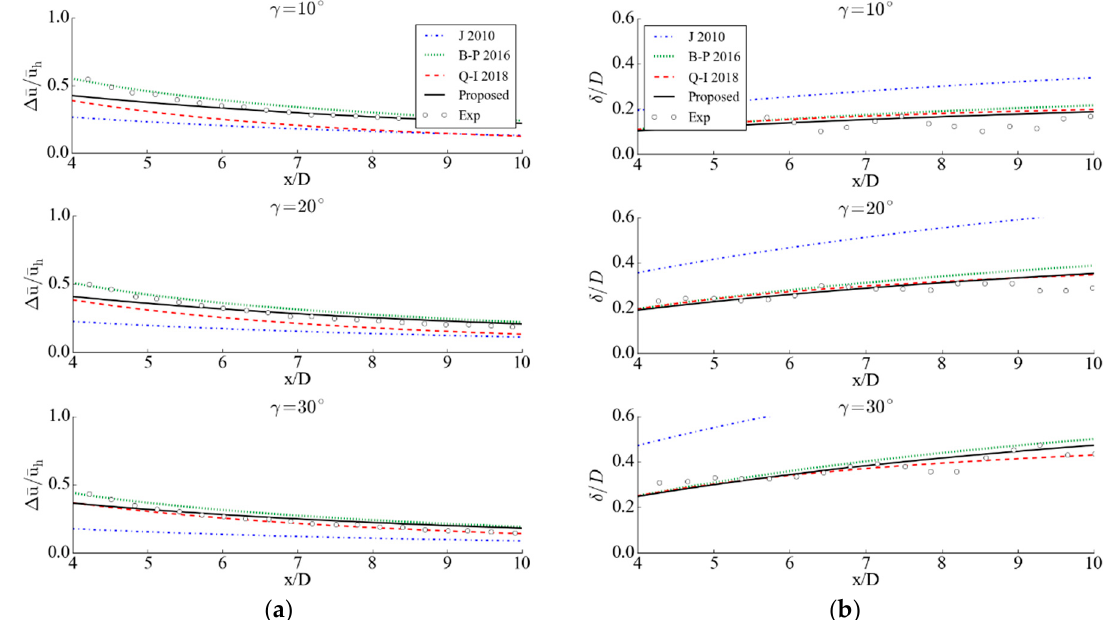
Figure 9. Comparisons of experimental results and model predictions: ( a ) maximum velocity deficit; ( b ) wake center deflection.